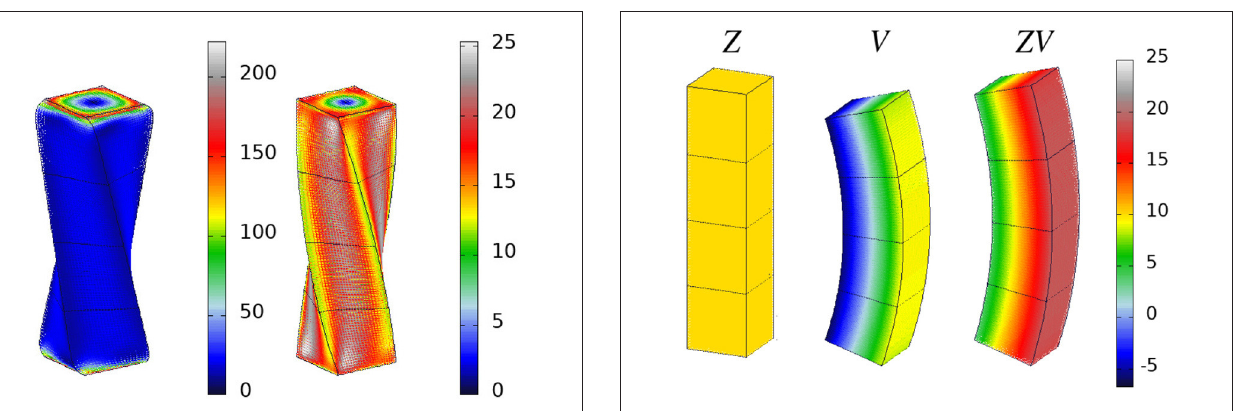
FIGURE A2 | Shear stresses in a square beam with large torsionl deformations (the same 90 ◦ rotation as in Figure A1 ). Version based on linear equations is shown on the left, and version based on non-linear equations is shown on the right.